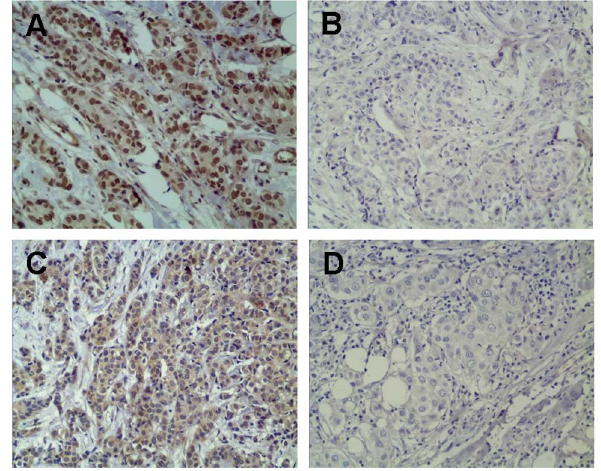
Figure 1. Representative immunohistochemistry images. MDM2 expression was demonstrated by brown-staining in the cell membrane or cytoplasm (A), while MMP-9 expression was shown as brown-staining in the nucleus or cytoplasm (C). The negative staining patterns are presented to enable a comparison (B, MDM2 negative, and D, MMP-9 negative).